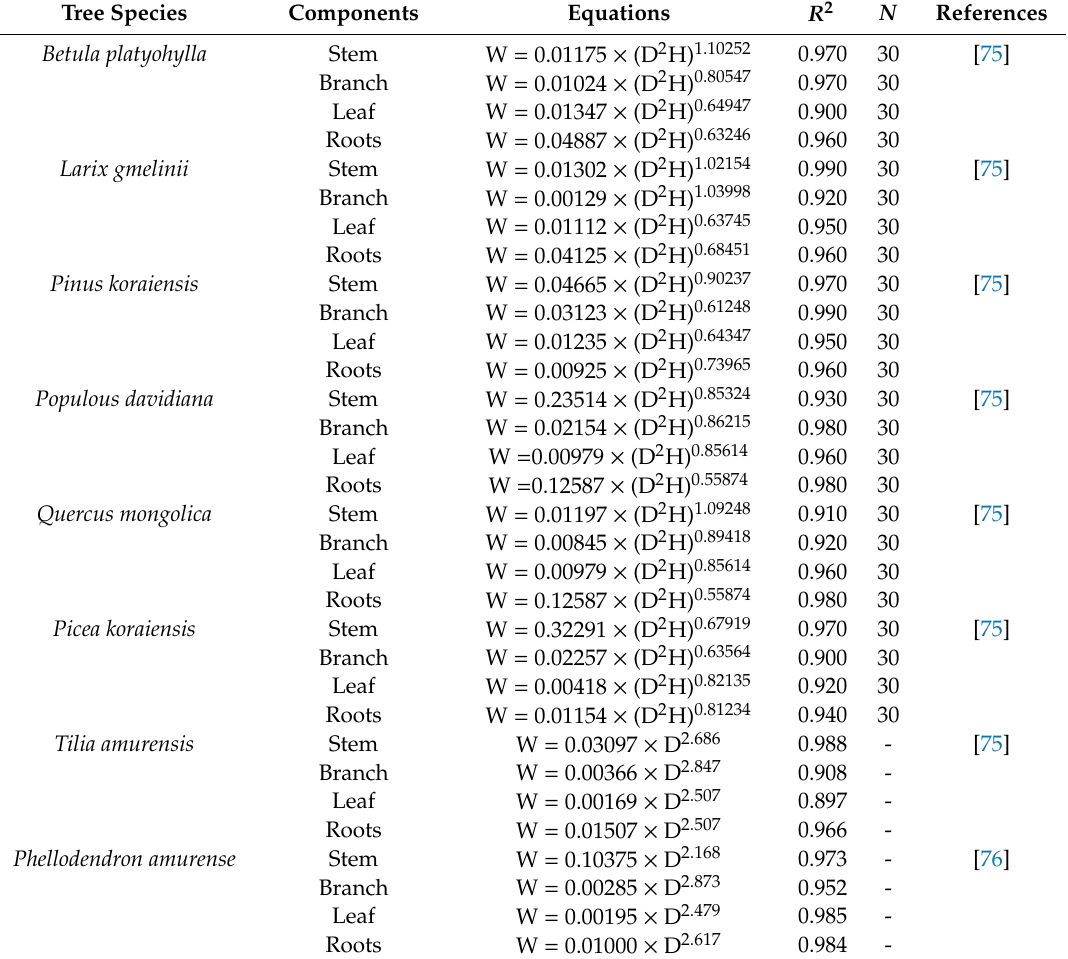
Table A1. Equations for calculating Stem, Branch, Leaf and Roots biomass of dominant tree species used in this study. D and H are diameter at breast height (cm), and height (m) of a tree, respectively. W is the biomass of the respective tree component (kg).